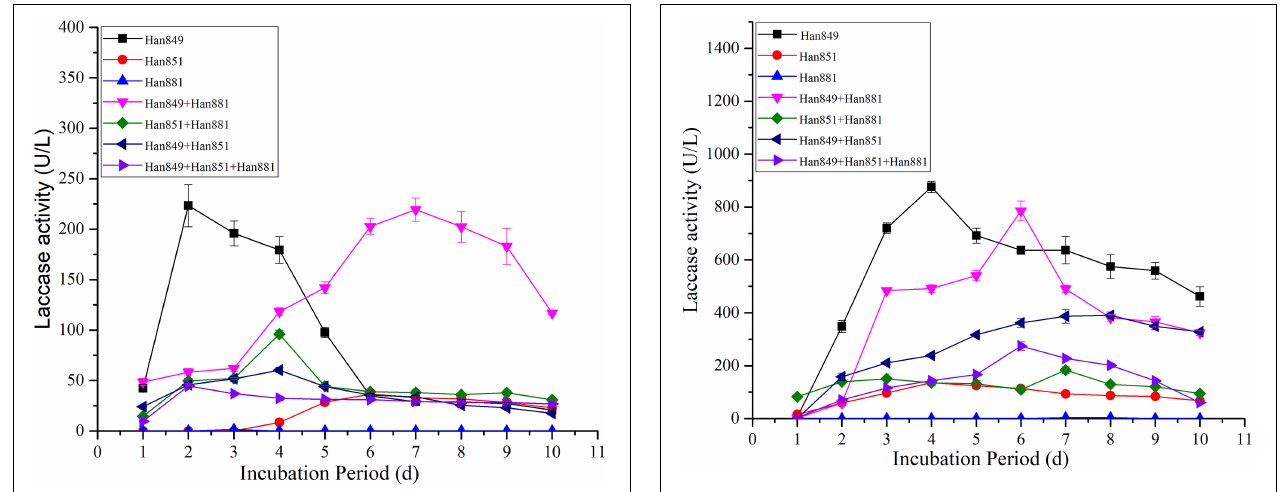
from other conditions on F. platanifolia was higher than that from P. tabuliformis or a mixture of P. tabuliformis and F. platanifolia . Maximum laccase activity from L. betulina Han 851 on F. platanifolia was 309.72 ± 12.53 U/L, nearly 8.47